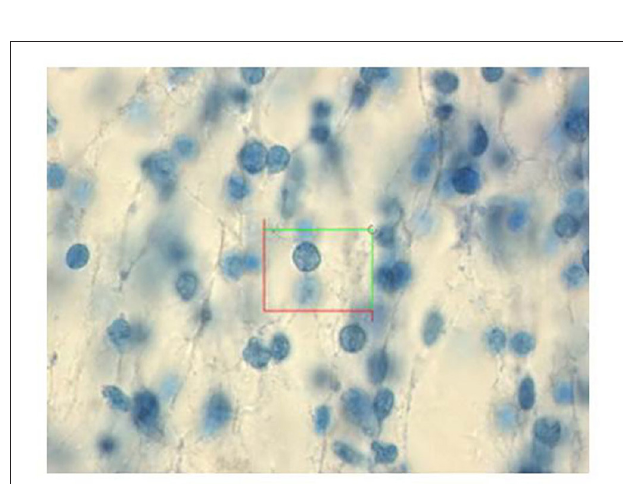
FIGURE 3 | “Coronal sections from a 24-weeks (A) , a 25-weeks (B) , and a 40-week-old (C) human fetus at the level of the basal ganglia. CP, cortical plate; SP, subplate; IZ, intermediatezone; VZ/SVZ, ventricular zone/subventricularzone. Scalebar 1 cm.” Reproduced with permission = from Walløe et al. (2014).